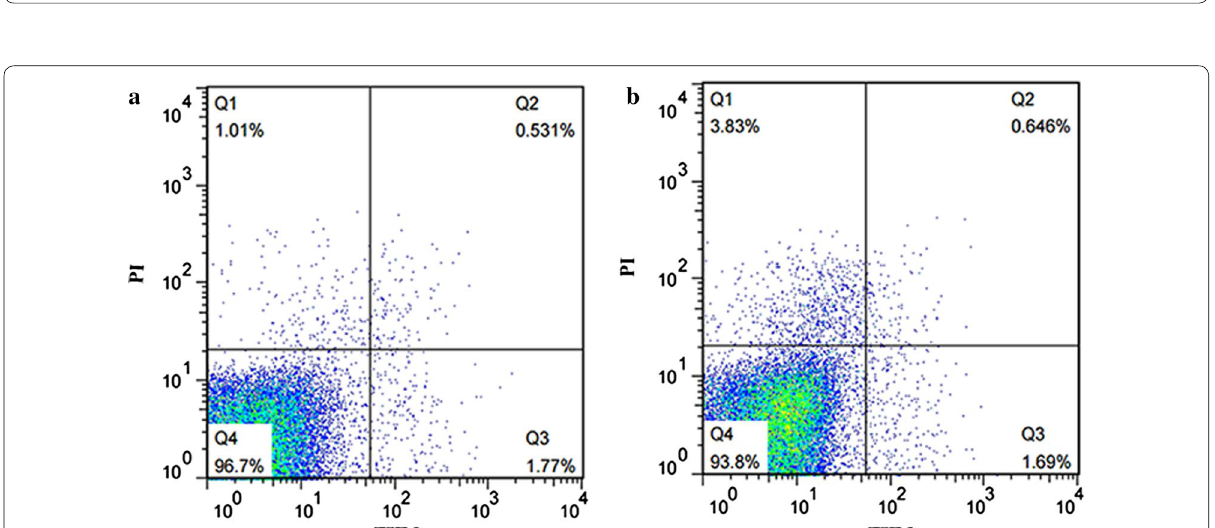
Fig. 7 Cell apoptosis profiles of P. pastoris GS115/ LacB ( a ) and P. pastoris GS115m/ LacB ( b ), respectively. Fluorescence intensities in 20,000 cells stained with the Annexin V-FITC/PI apoptosis detection kit were monitored by flow